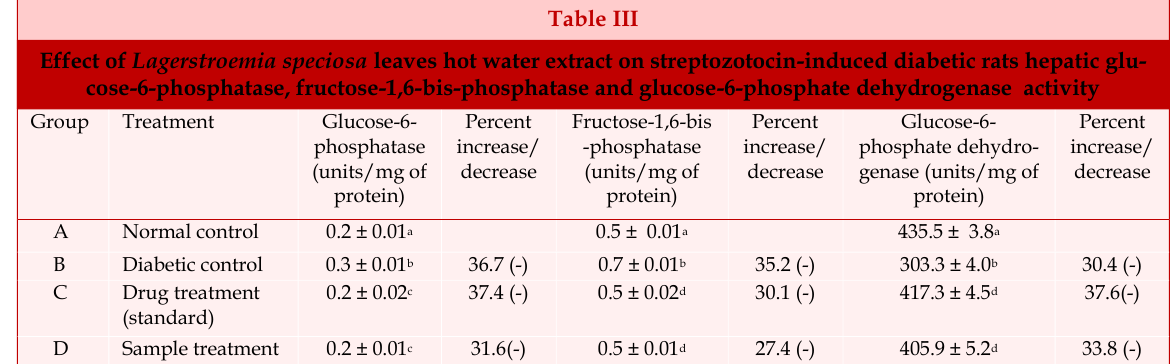
blood glutathione (a tripeptide of glycine, cystein and glutamic acid, GSH) level of chemically induced